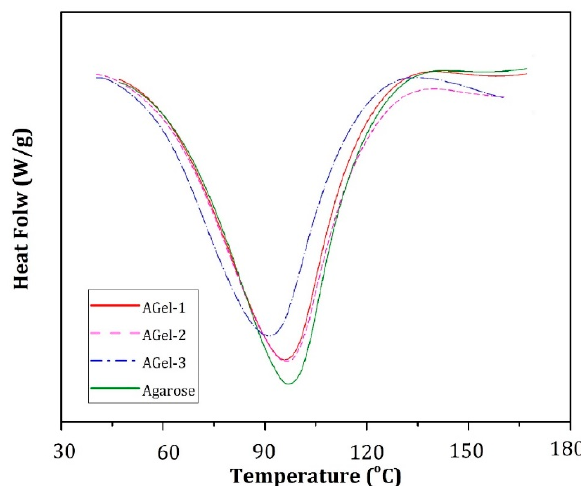
Figure 2. Overlaid differential scanning calorimetry (DSC) thermograms of the Agarose and AGel-1, AGel-2 and AGel-3 composites.